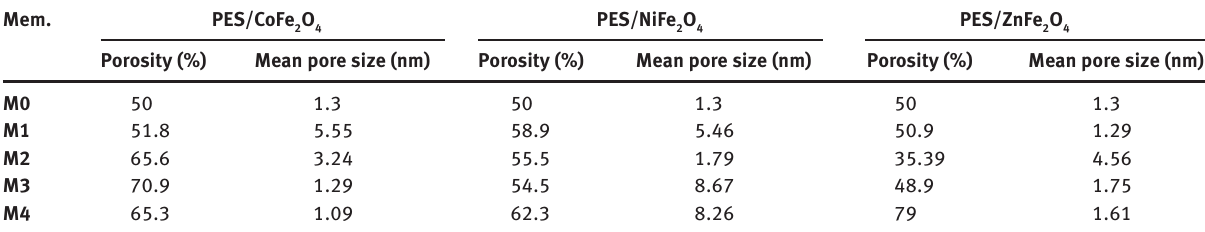
Table 1: Porosity and mean pore size of the pure PES membrane and the modified membranes